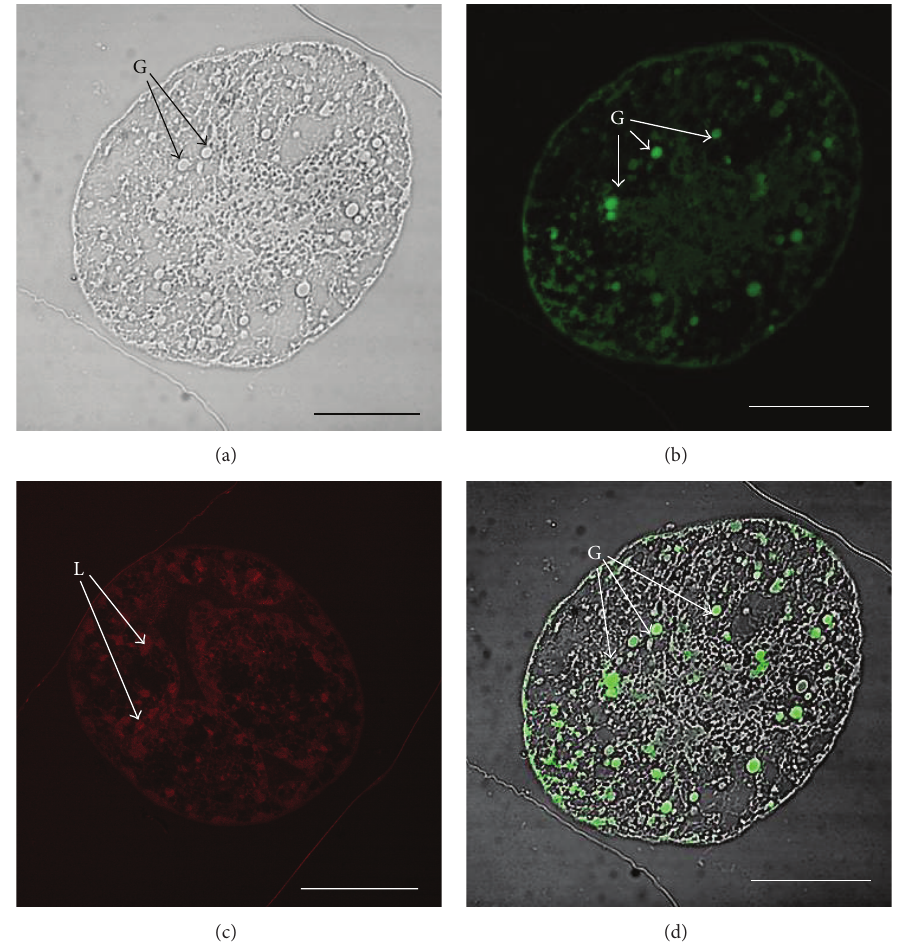
Figure 4: Semithin sections of teratocytes were dual-stained with NBDC 6 for Golgi apparatus and Lysotracker for lysosomes. (a) Transmitted light micrograph of teratocyte showing internal structure of the cell. (b) Same cell section stained with NBDC 6 showing strong staining of the Golgi distributed mostly around the periphery of the nucleus. (c) Same section stained with Lysotracker showing distribution of lysosomes (red) within the teratocyte. (d) Overlaid images of (a)–(c) showing Golgi around nucleus. G: Golgi apparatus, L: lysosomes. Scale bars = 20 𝜇